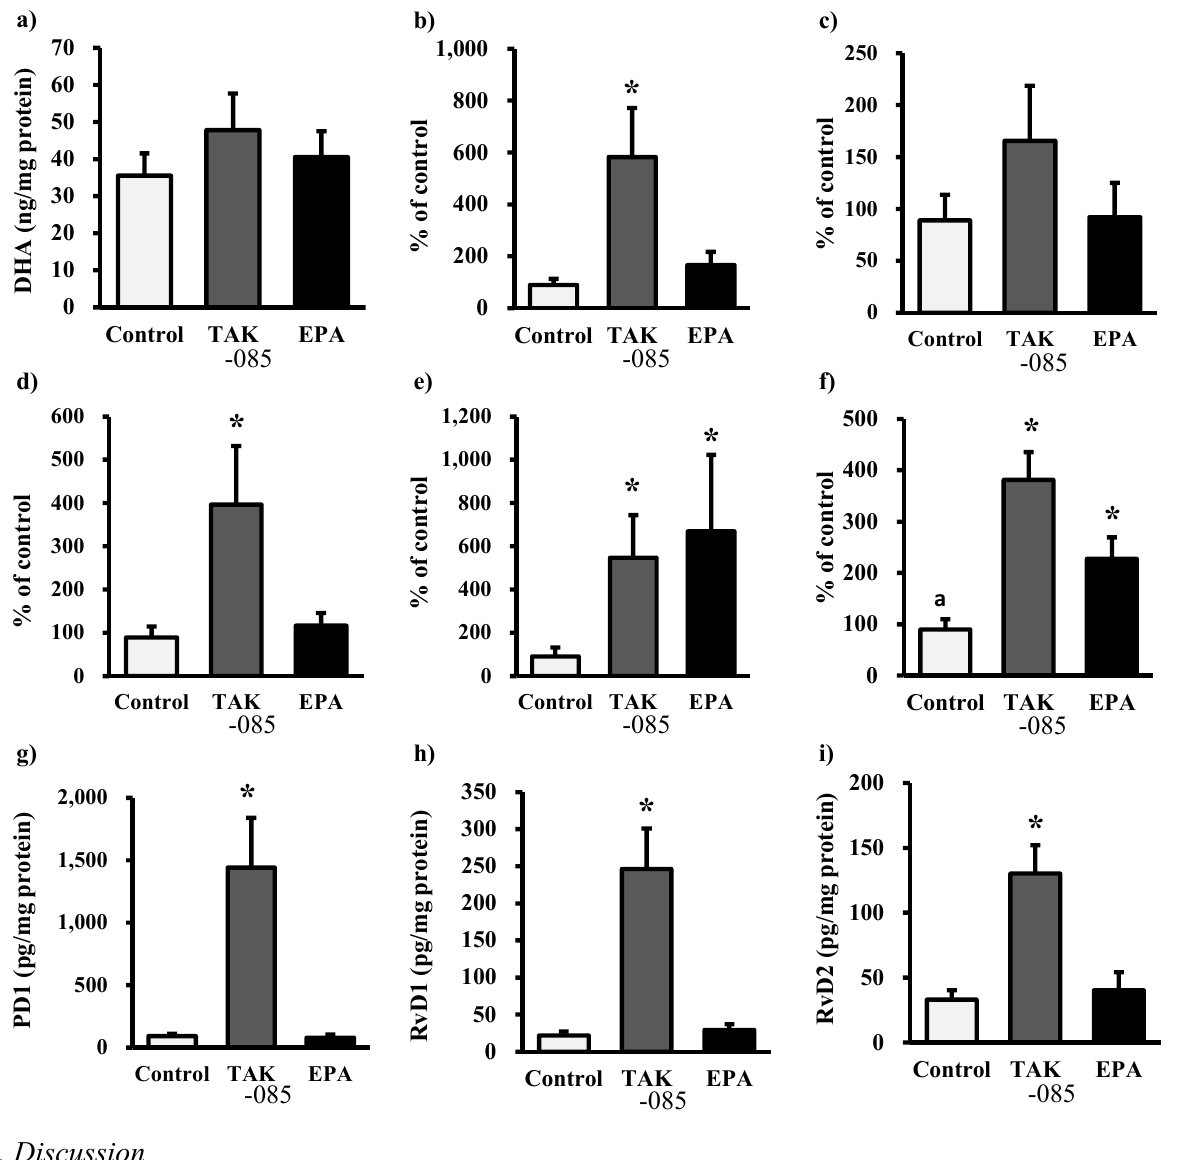
Figure 5. Renal levels of DHA-derived docosanoids. ( a ) Nonesterified DHA, ( b ) 7-HDoHE, ( c ) 13-HDoHE, ( d ) 10-HDoHE, ( e ) 14-HDoHE, ( f ) 17-HDoHE, ( g ) PD1, (h) RvD1, and ( i ) RvD2. Values are presented as mean ± SE (n = 10–11). Statistical analysis was performed by one-way ANOVA followed by Dunnett’s test. * P < 0.05 vs. control